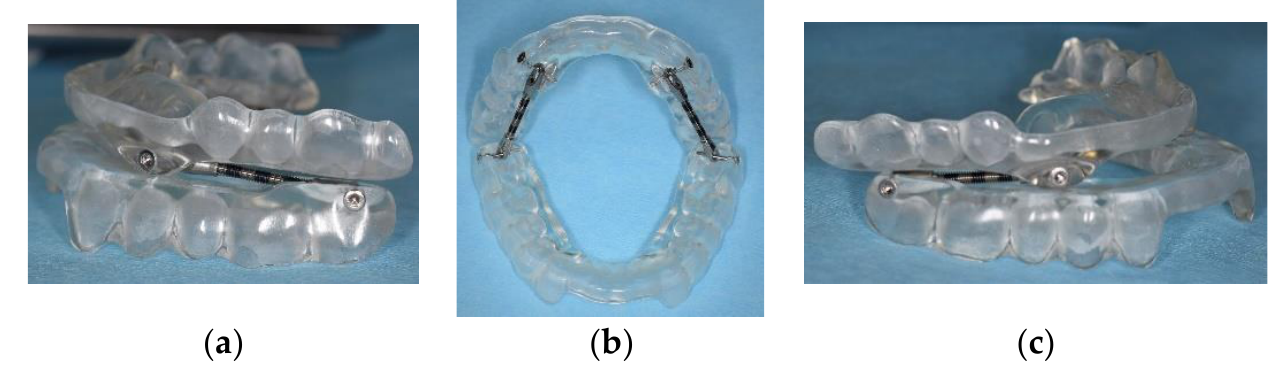
Figure 1. Mandibular Advancement Device. ( a ) left lateral view, ( b ) frontal view, ( c ) right lateral view